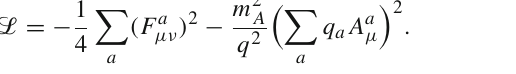
/ e 2 irrational. If the direction A B